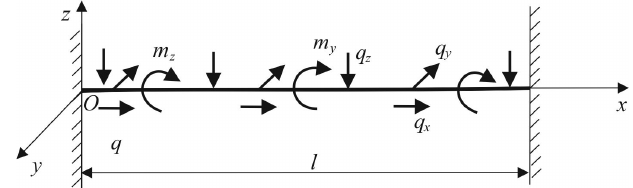
Figure 5. A rod pinched at both ends